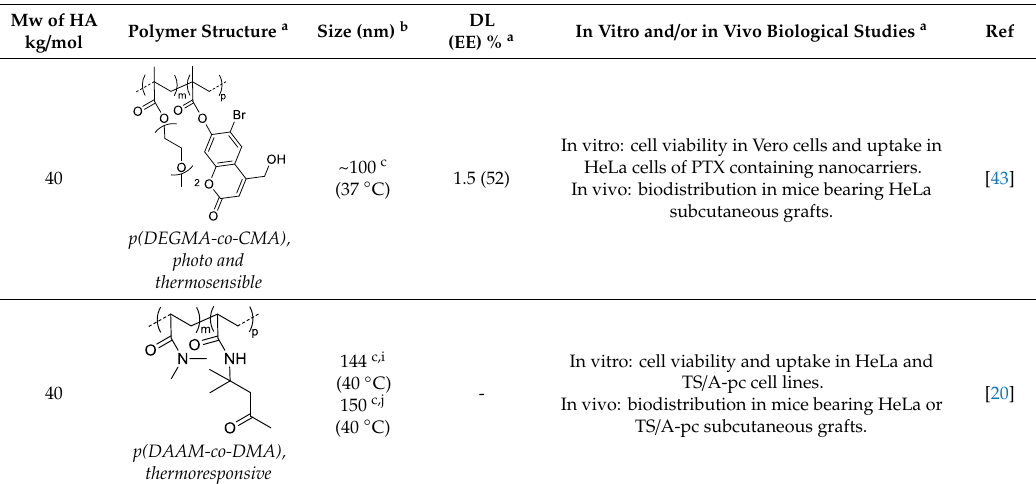
In vitro: cell viability and uptake in HeLa and TS/A-pc cell lines. In vivo: biodistribution in mice bearing HeLa or TS/A-pc subcutaneous grafts. a abbreviations: PLA: Poly(lactide), PEG: polyethylene glycol, SMA: poly-(styrene-co-maleic anhydride, PEI: poly(polyethyleneimine), pDEAEMA: poly-N,N-diethylaminoethylmethacrylate, a abbreviations: PLA:Poly(lactide),PEG:polyethyleneglycol,SMA:poly-(styrene-co-maleicanhydride,PEI:poly(polyethyleneimine), pDEAEMA: poly-N,N-diethylaminoethylmethacrylate, pHis: poly(histidine), PDIPASP: poly(diisopropylaminoethyl)aspartamide, p(DEGMA-co-OEGMA): poly(diethylene glycol methacrylate-co-oligoethylene glycol methacrylate), p(DEGMA-co-BMA):